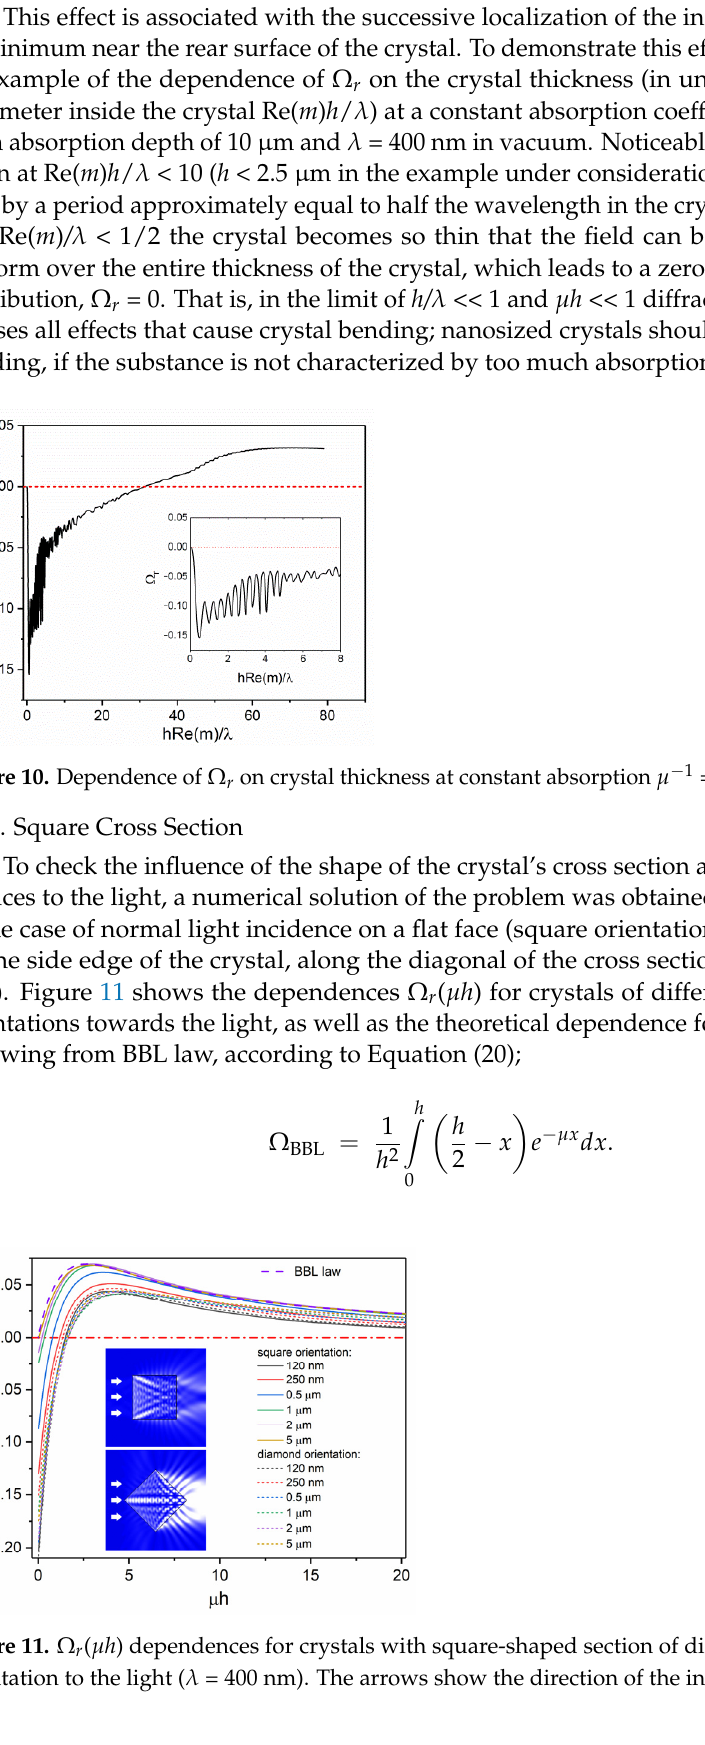
Figure 9. Dependences of the reduced moment of intensity Ω r (Equation (19)) on the parameter of light absorption in a crystal μ h for crystals of different thicknesses ( λ = 400 nm).